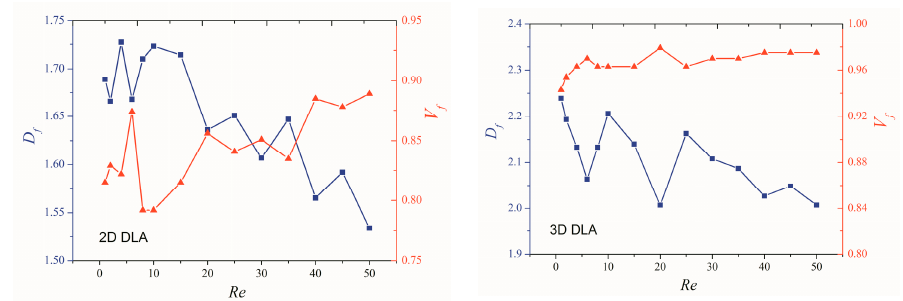
Figure 10. Effect of launch radius on the fractal dimension and porosity of 2D and 3D DLA aggregates.